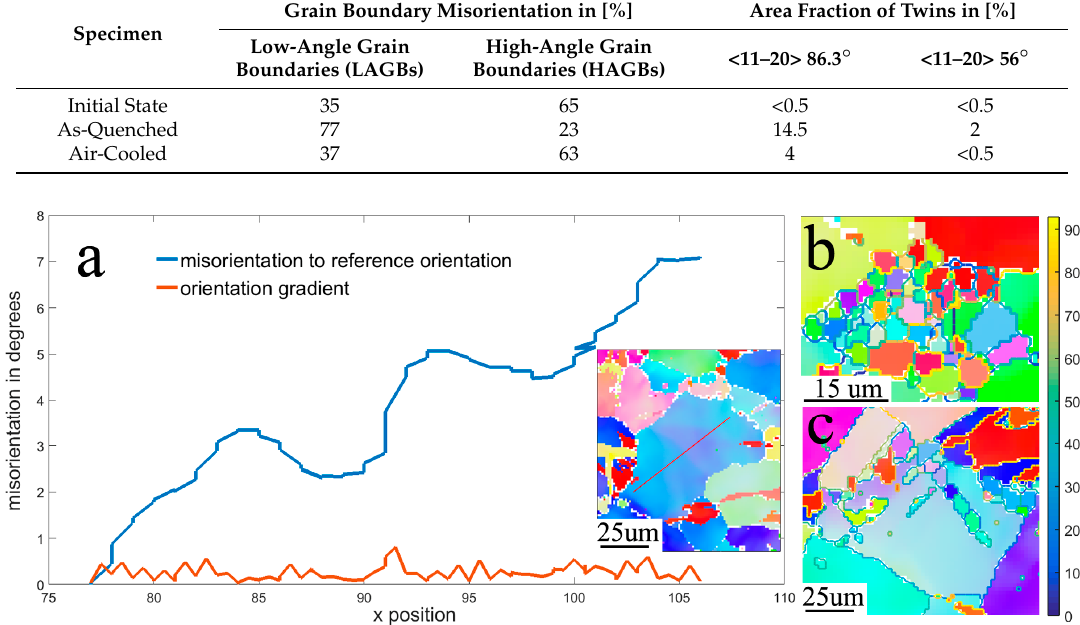
Figure 4. ( a ) a spatial profile extracted from a coarse grain presented in the inset to the right; ( b ) closely stacked fine grains in a coarse grain; ( c ) coarse grain that include fine grains nucleated from a fragmented twin.